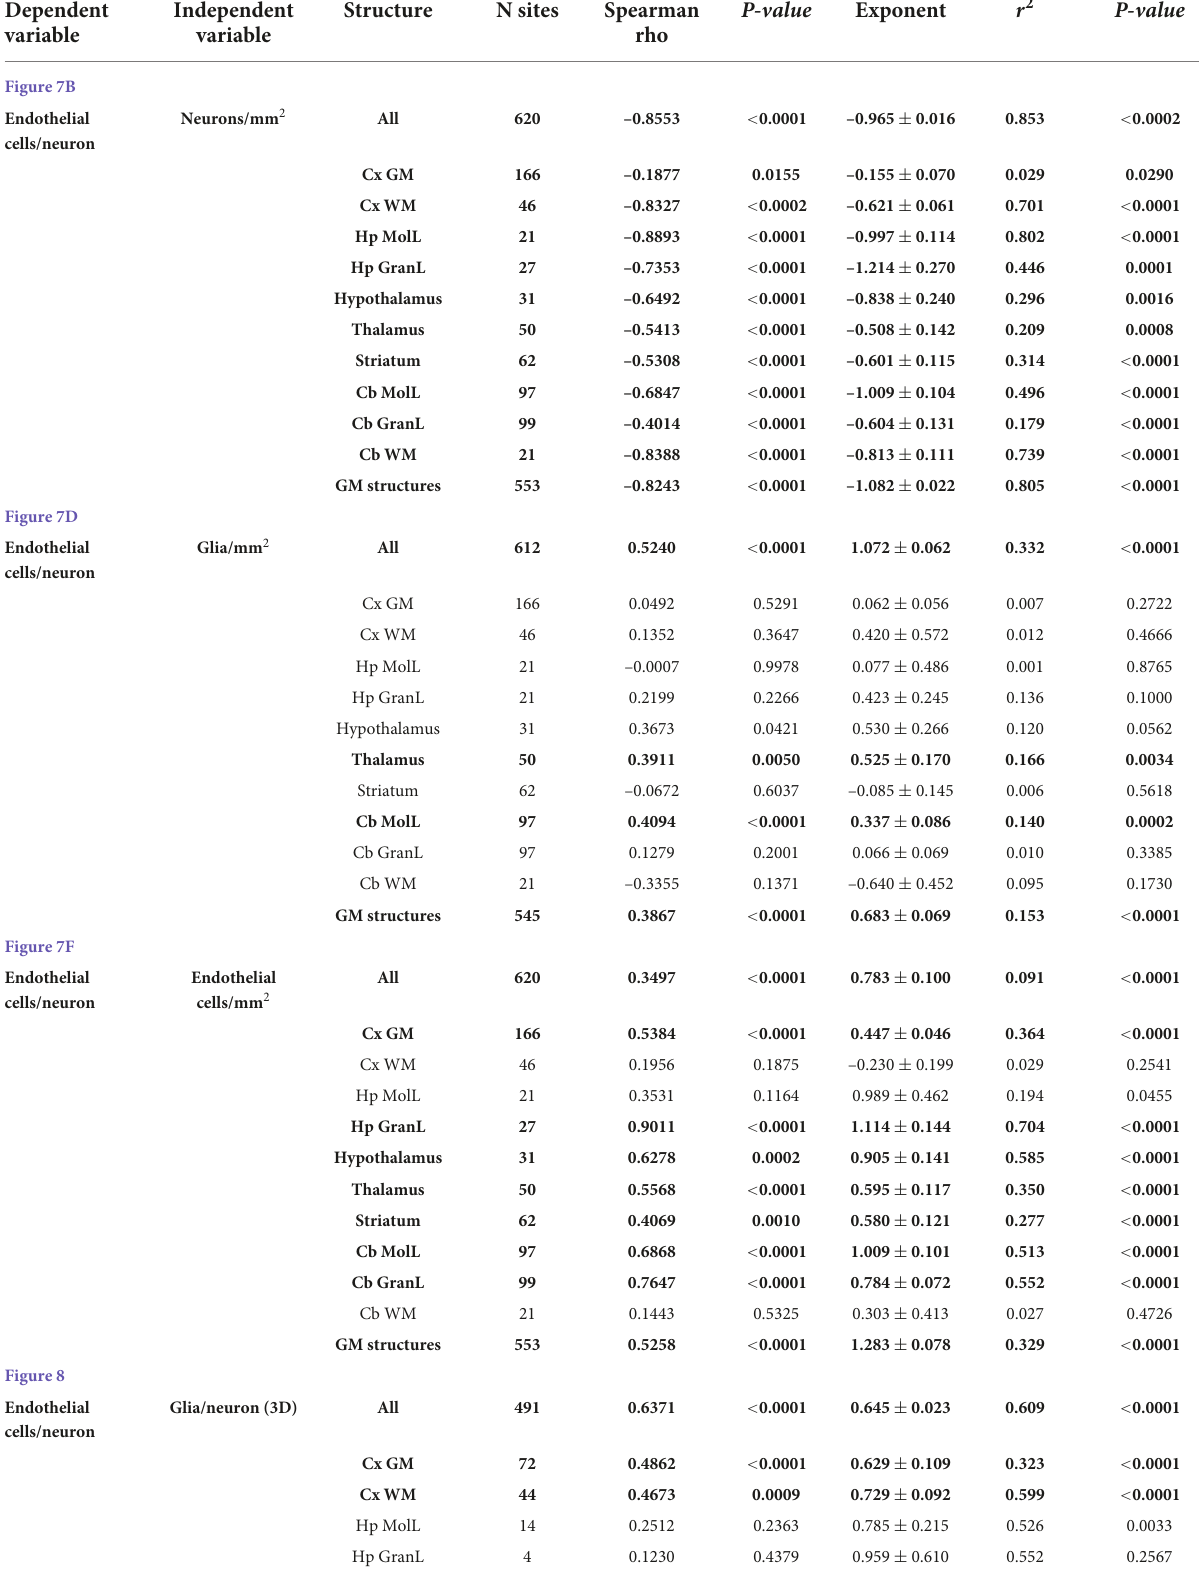
Figure 8 Endothelial